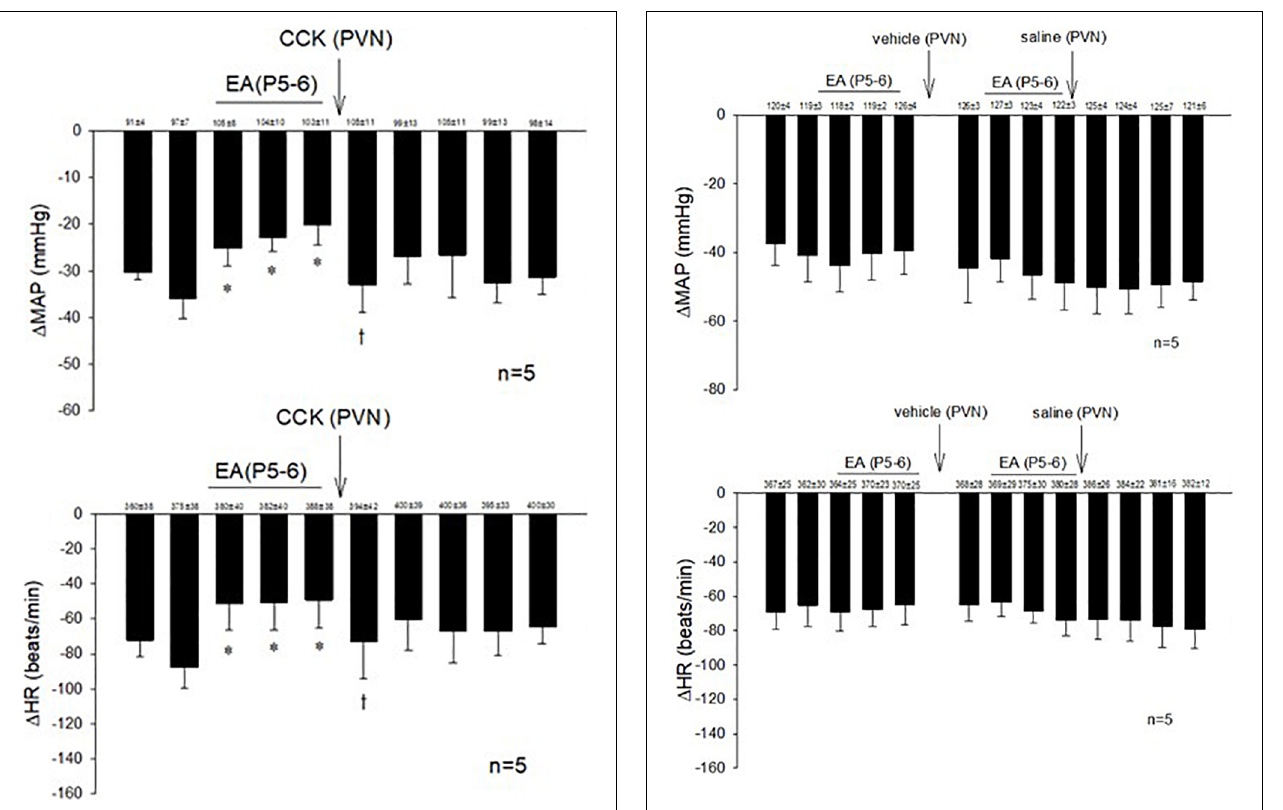
FIGURE 3 | The role of CCK in the effects of EA during hypotensive and bradycardia responses. PVN microinjection of the agonist CCK-8 inhibited the effect of EA modulation of the cardiopulmonary responses. Baselines blood pressures and heart rates in mean ± SEM shown above bars were not significantly different throughout experiments. ∗ Significant difference compared with control PBG response. † Significantly different compared with the preceding PBG response.